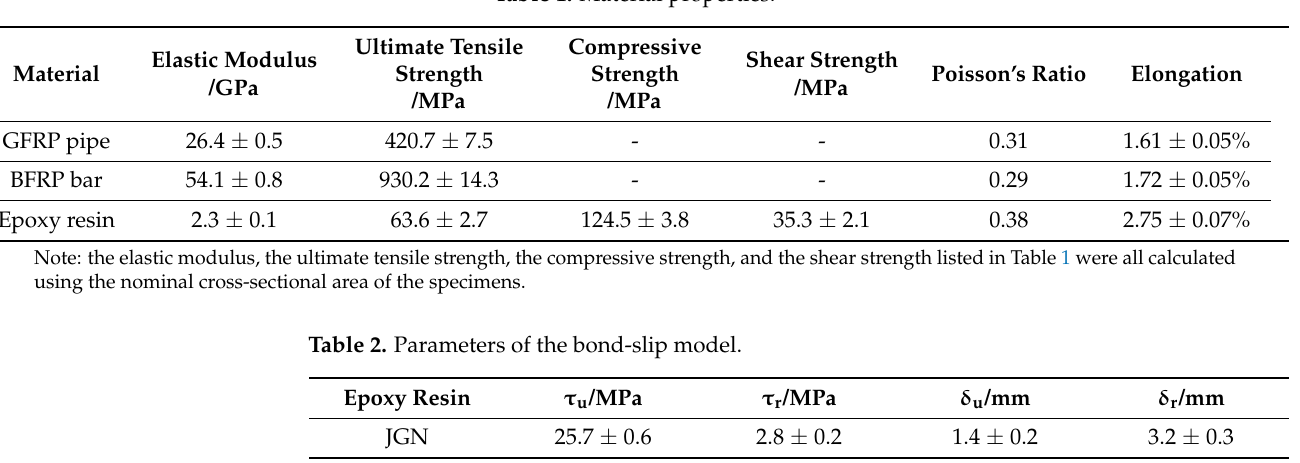
Table 1. Material properties.